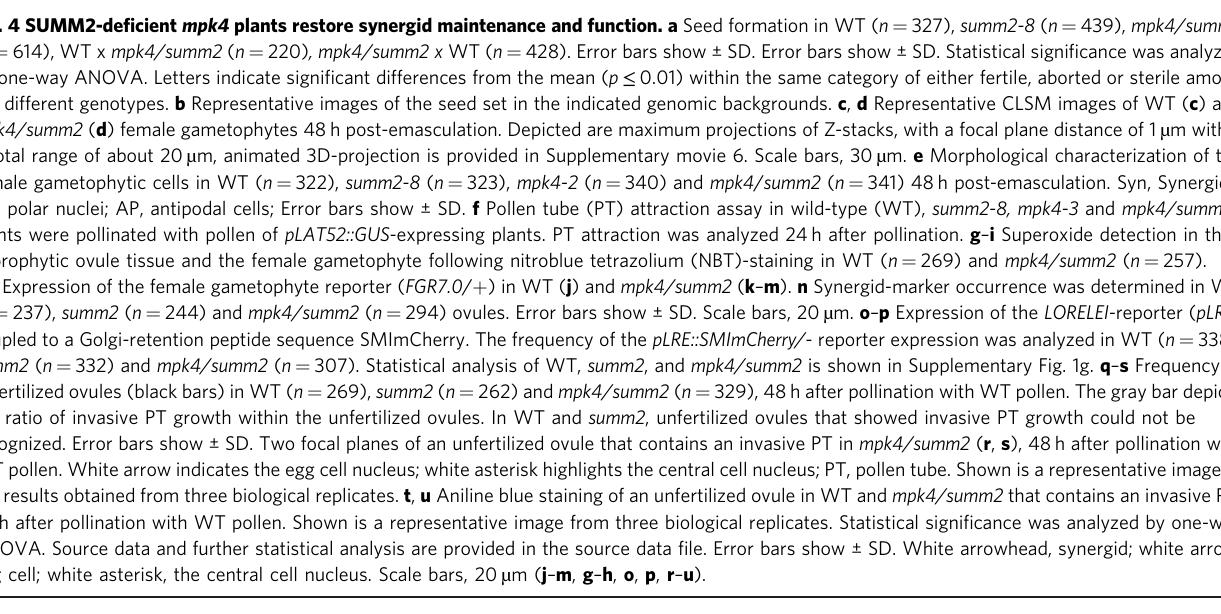
egg cell; white asterisk, the central cell nucleus. Scale bars, 20 µ m ( j – m , g – h , o , p , r – u